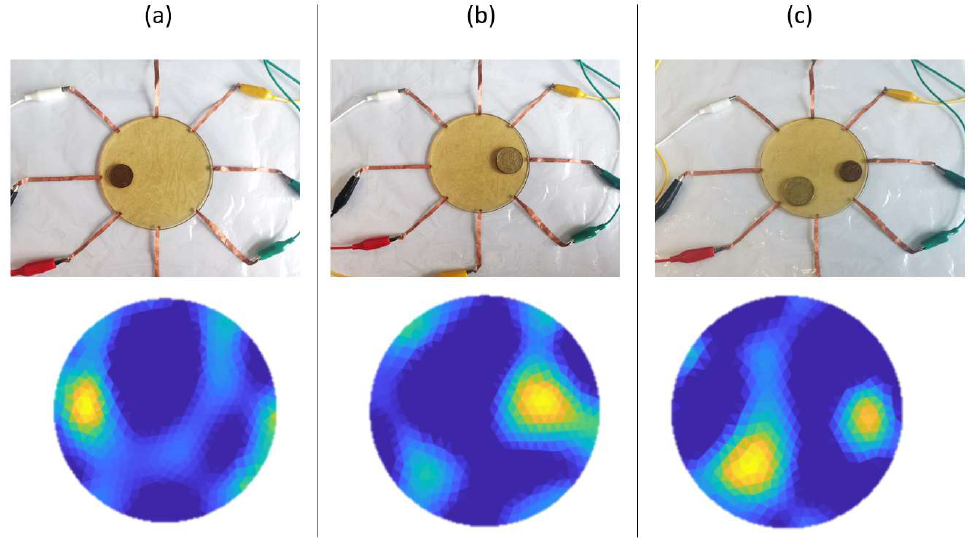
Figure 7. The proposed sensor can distinguish the difference in the contact area. ( a ) A 10 cents coin with a diameter of 20.5 mm is placed onto the sensor. ( b ) A 2 dollars coin with a diameter of 26.5 mm is placed onto the sensor. ( c ) Both coins are placed onto the sensor.